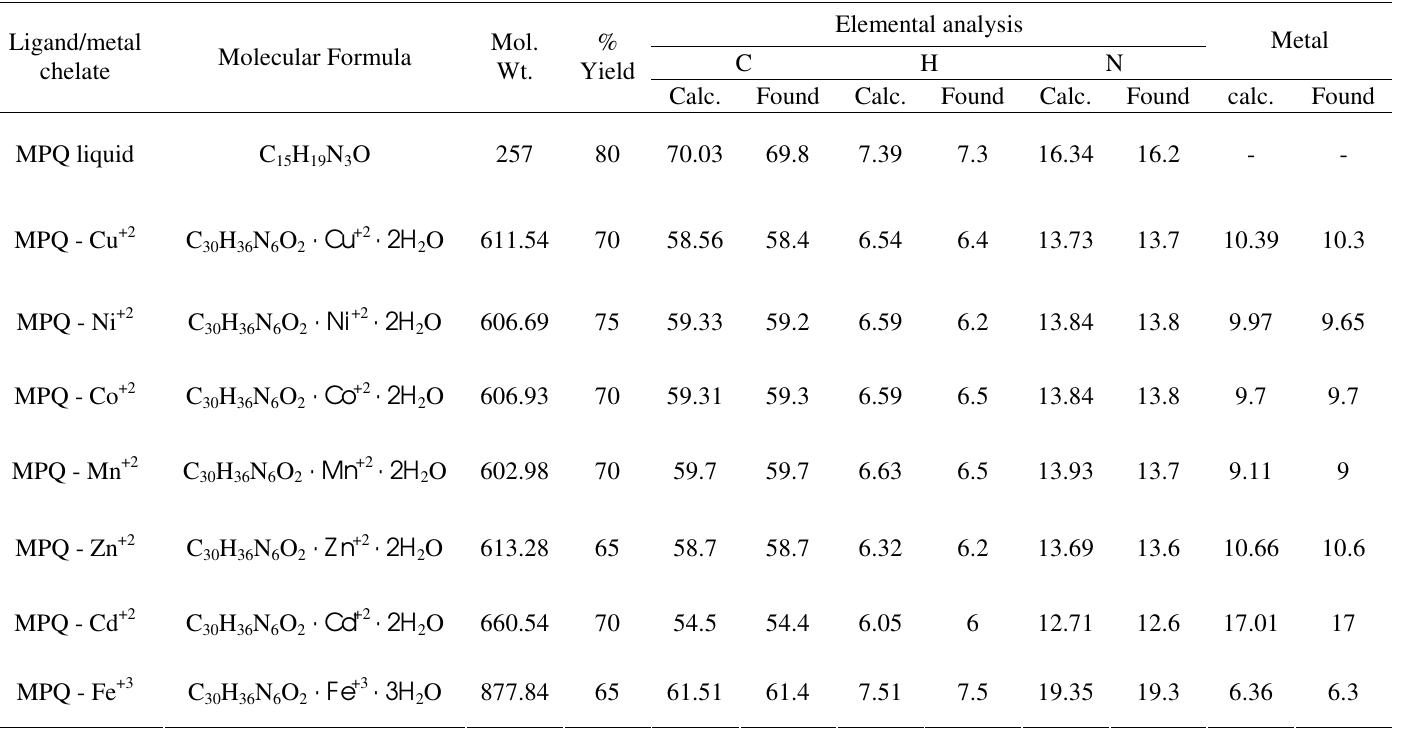
Table 1 . Analysis of MPQ Ligand and Its’ Metal